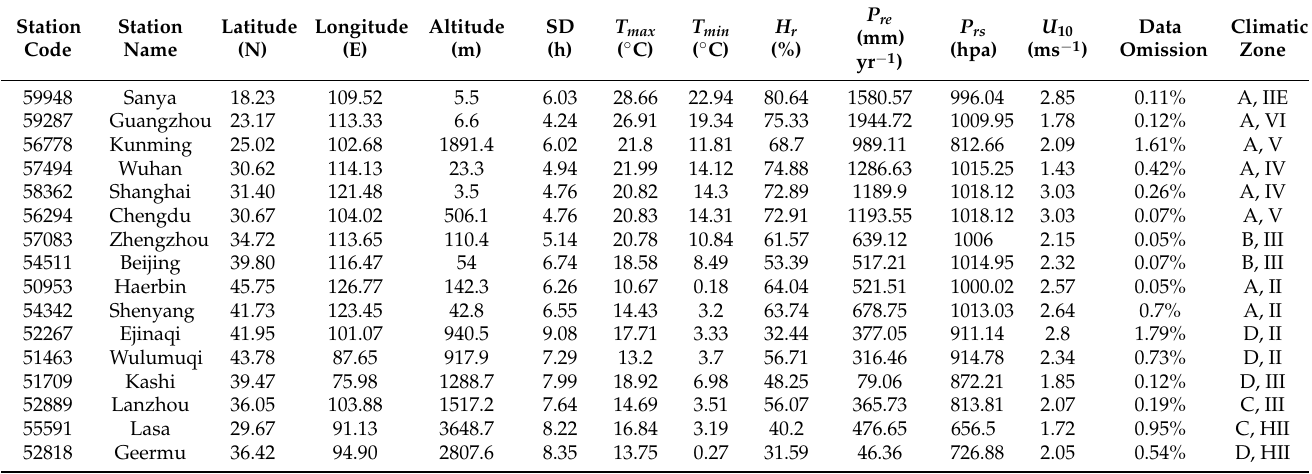
Table 1. The geographical locations of 16 stations and information regarding various meteorological